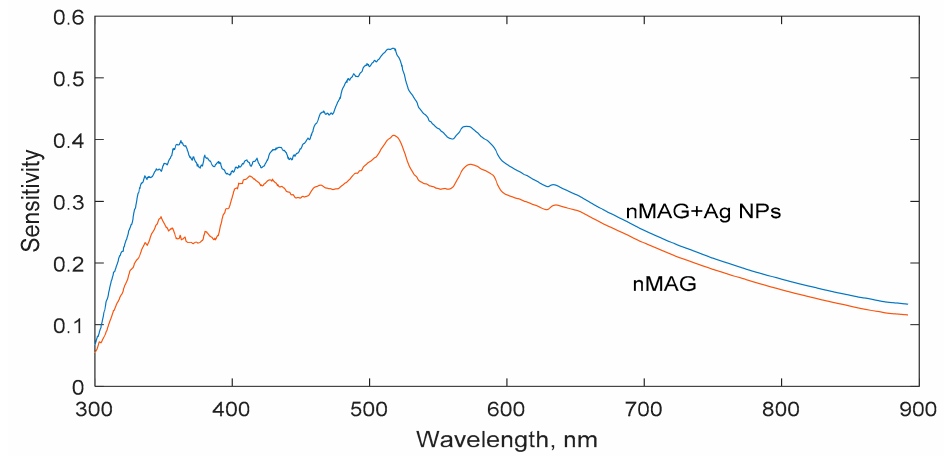
Figure 1. Variations of dose sensitivity of nMAG and nanoparticle-enriched nMAG dose